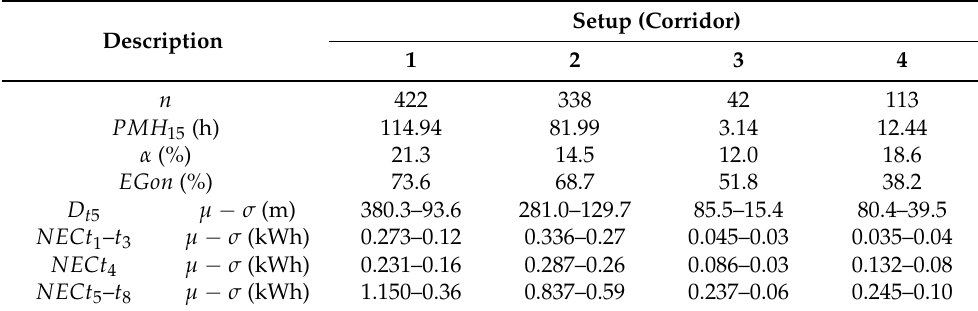
Table 5. Statistical transport data and energy consumption of the hybrid TY in various uphill configurations making use of both the haulback and mainline drums